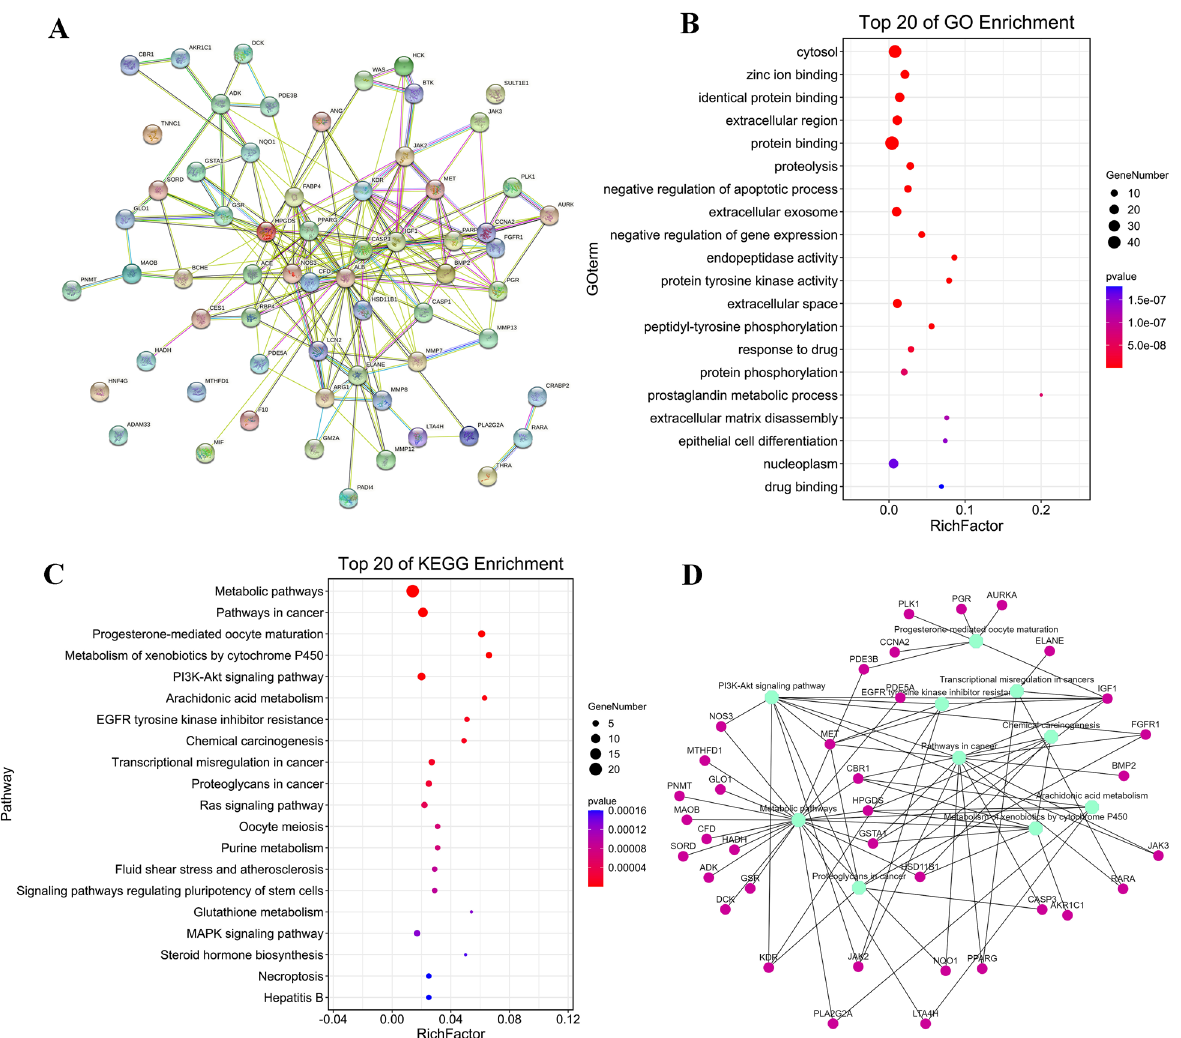
Figure 2. PPI network, GO and KEGG analyses of all DEGs related TSA. ( A ) PPI network constructed by STRING. ( B ) Go analysis items. ( C ) KEGG pathways. ( D ) Network of interactions between the top 10 pathways and 64 target genes, the green indicates the pathways, the pink indicates the